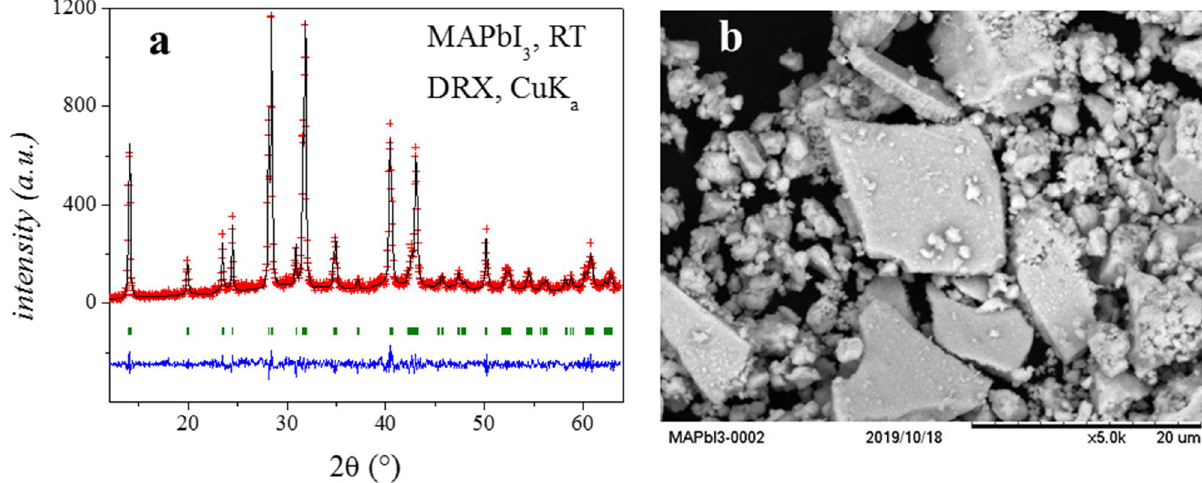
Figure 1. ( a ) Le-Bail refinement from a laboratory XRD pattern at RT of MAPbI 3 . ( b ) SEM image of as-prepared